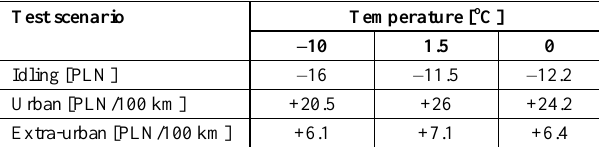
Table 1. The difference in the total cost of driving per test with an electric heater across different test scenarios and ambient